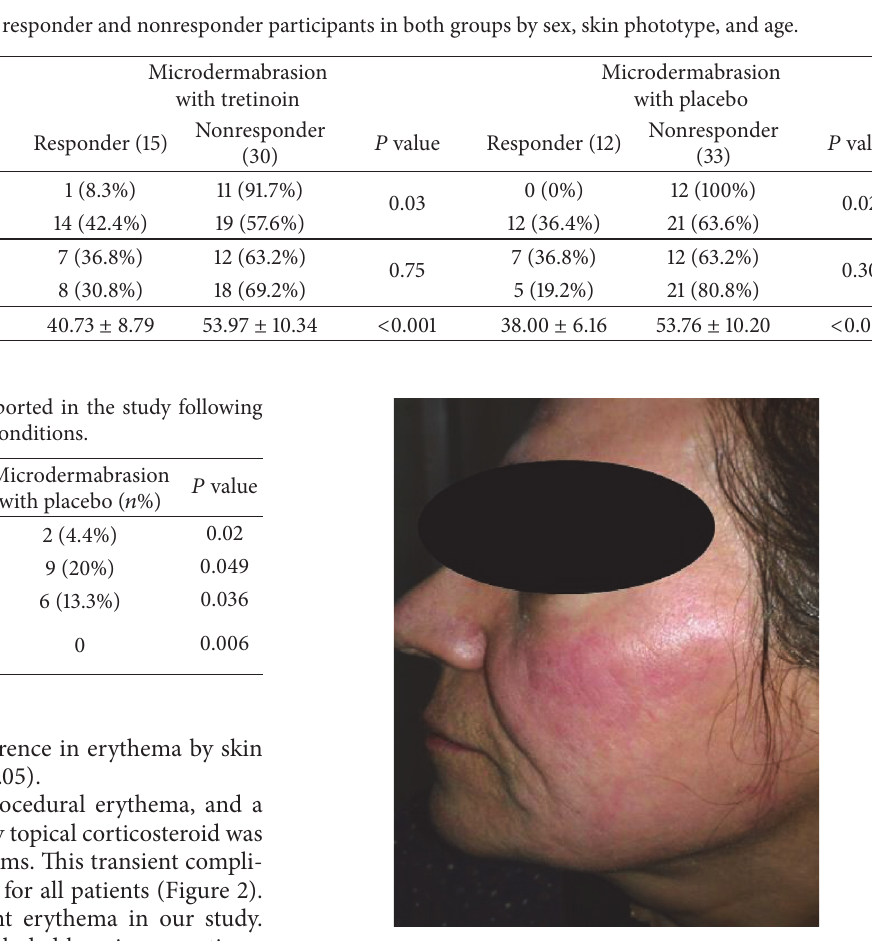
Figure 2: Erythema at the site of application 5% retinoic acid peel combined with microdermabrasion in a 35-year-old female. The erythema gradually faded after 3